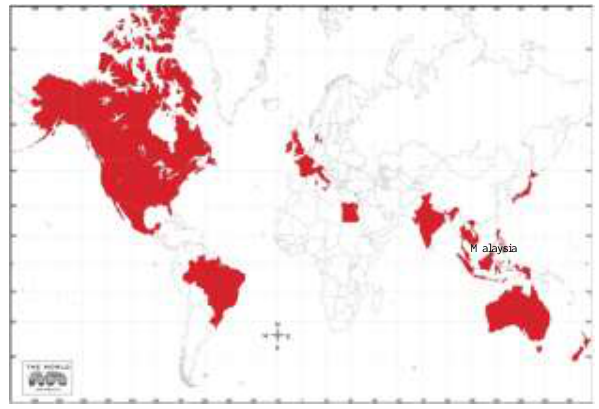
Figure 1. Distribution of the countries that imposed drone regulation until